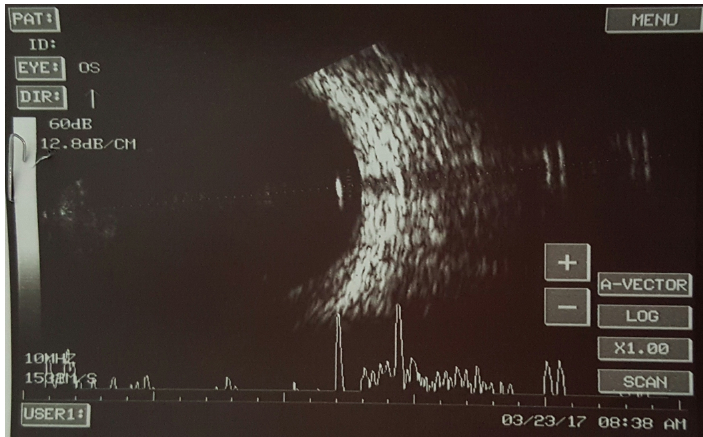
Figure 2: Ultrasonography following the initial surgery showing a hyperintense lesion with backshadowing suggestive of a foreign body